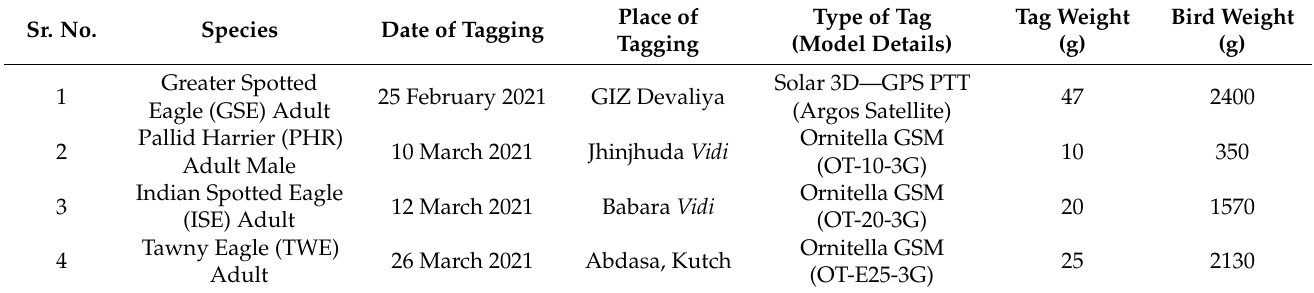
Table 1. Details of satellite tagging of selected migratory raptor species in Asiatic Lion Landscape, Gujarat,